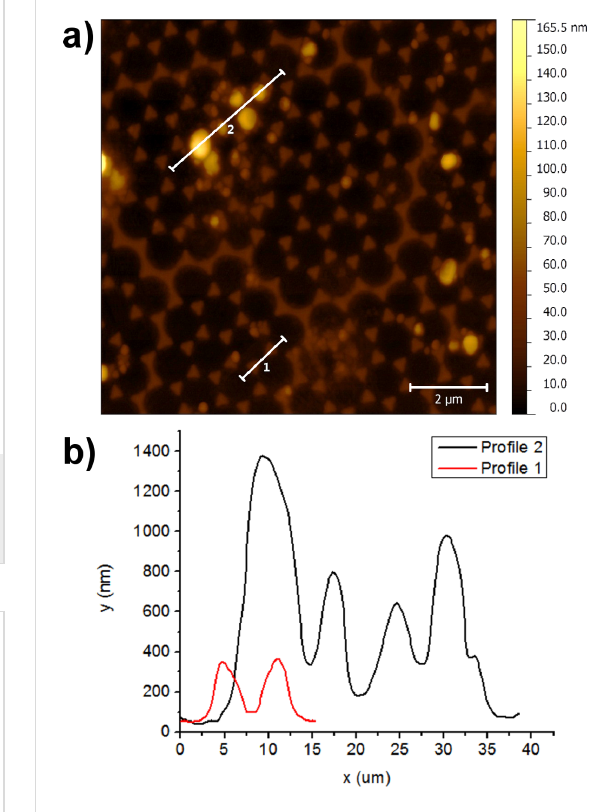
Figure 16: (a) AFM image of the spin coated TiO 2 :Eu layer. The antenna structure is still visible in this region. (b) AFM height profiles along the lines marked in (a) (black line corresponds to line 2 in (a), red line to line 1 in (a)).